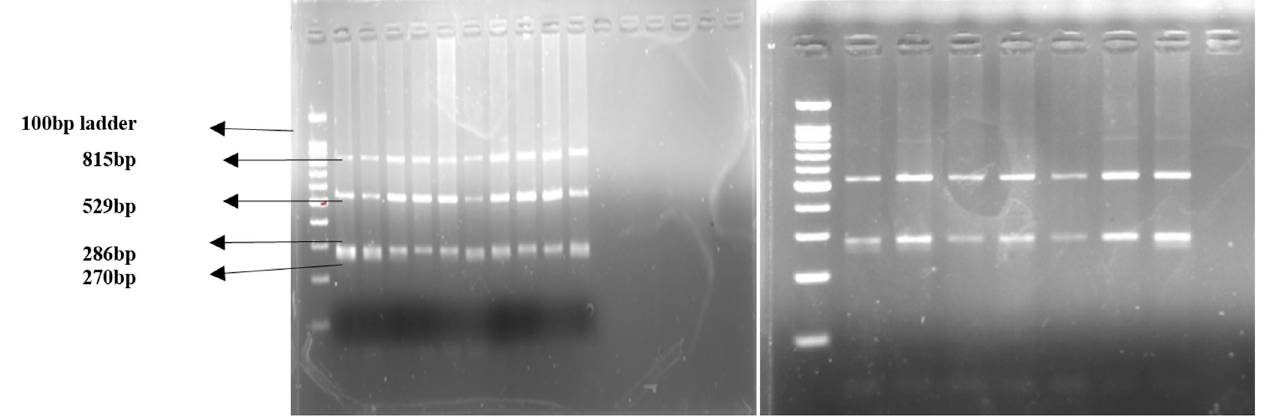
Figure 10. Pattern of IL17A restriction products after digestion with EcoNI enzyme. Table 3. Pattern of genotype and allele frequencies in IL17A (G/A) gene polymorphism.